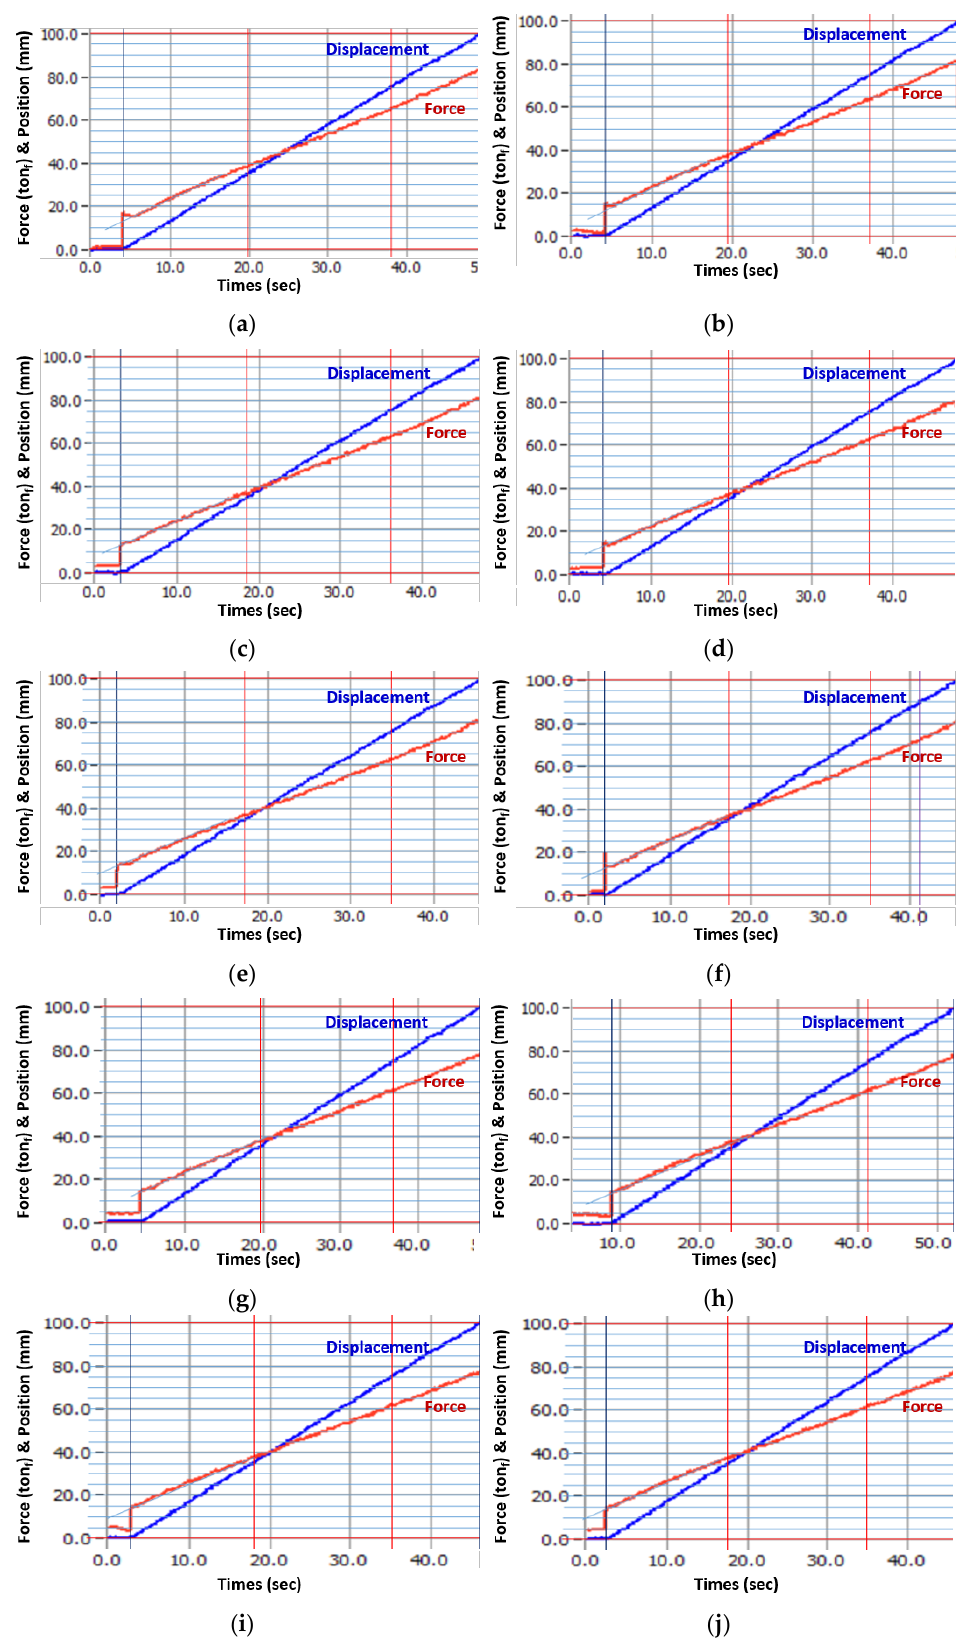
Figure 3. Shear force (red line) and displacement (blue line) graph through performance evaluation (10 times raw test